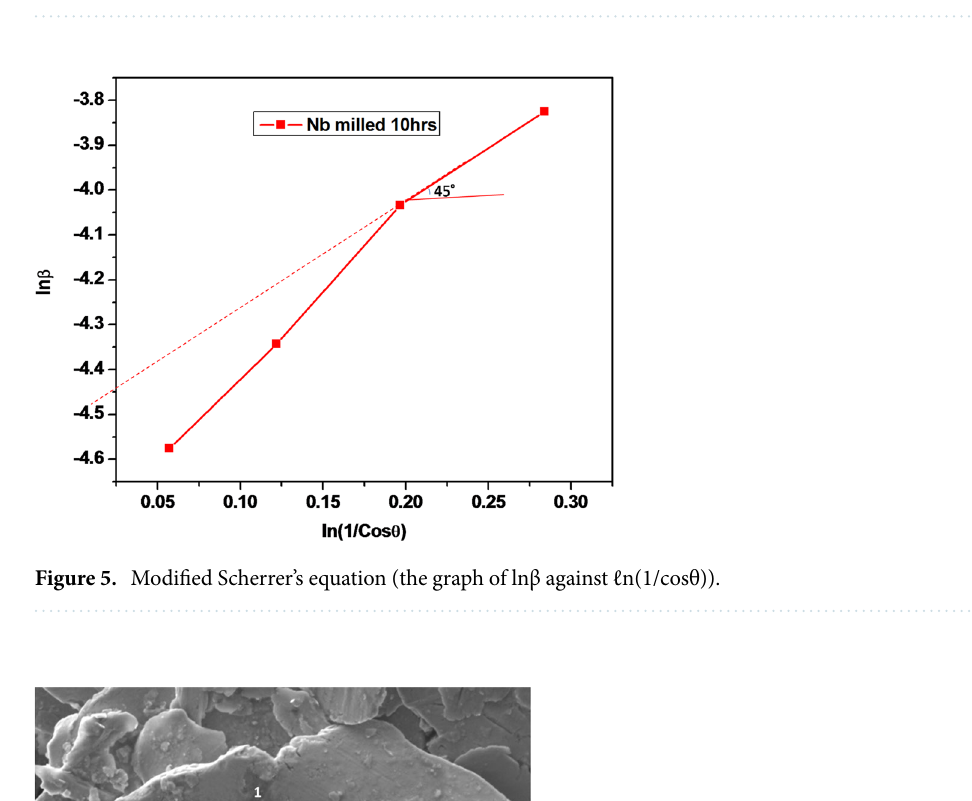
Table 2. The summary of the data obtained from the modified Scherrer equation (values of lnβ and ℓn(1/ cosθ))of the milled powders.